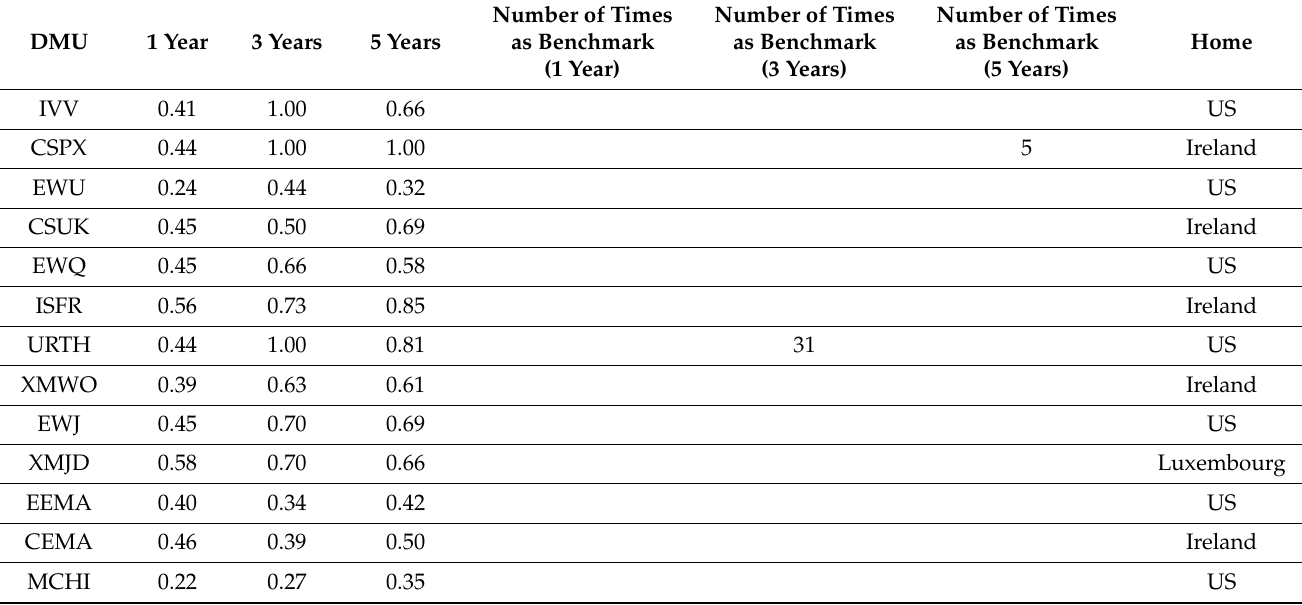
Table A4. Efficiency scores and benchmarks computed with model